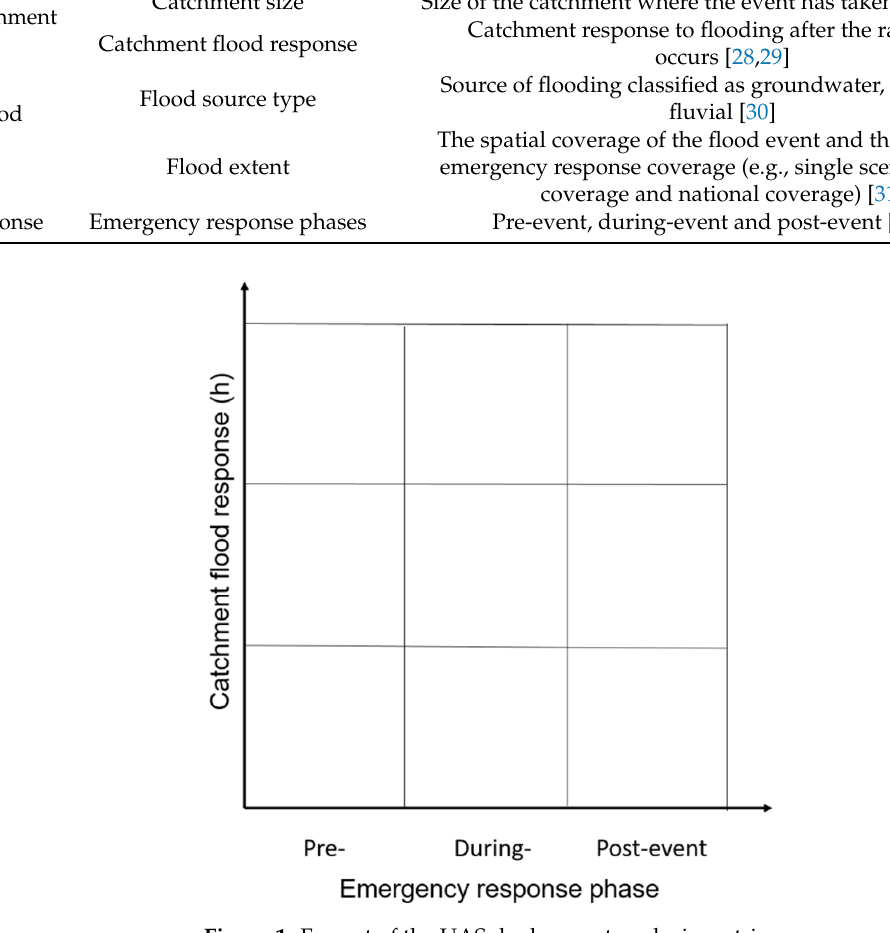
Figure 1. Format of the UAS deployment analysis matrix .